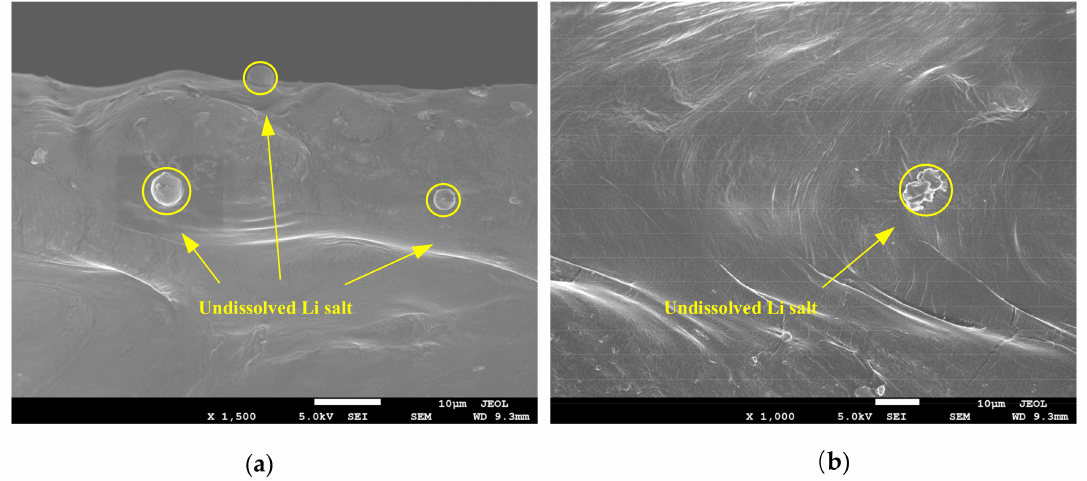
Figure 12. SEM observation of the electrolyte: ( a ) from Group A, and ( b ) from Group B.